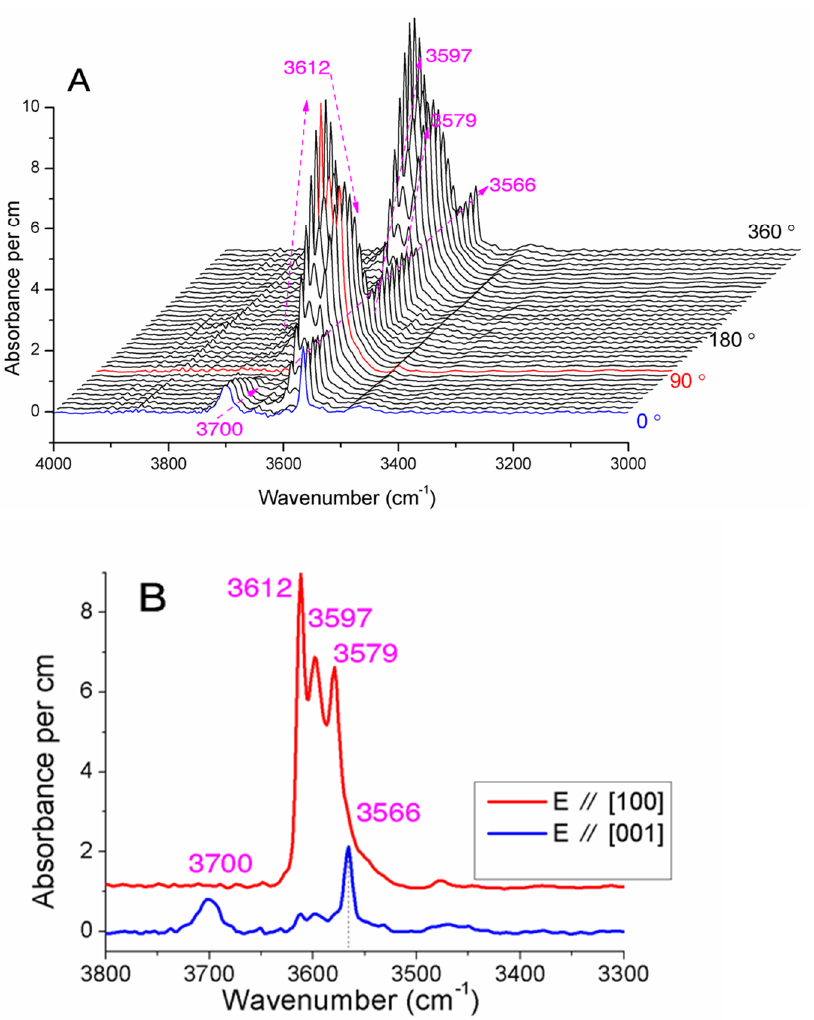
Figure 4. ( A ) IR absorption spectra of polarized IR propagating vector ⊥ (010) plane of forsterite, (E vector of light vibrating parallel to the c axis was labeled as 0 ◦ ) show the angle between IR light vibrating vector and the original directions (360 ◦ in total with a 10 ◦ interval). ( B ) The IR absorption spectra of the [100] and [001] direction.